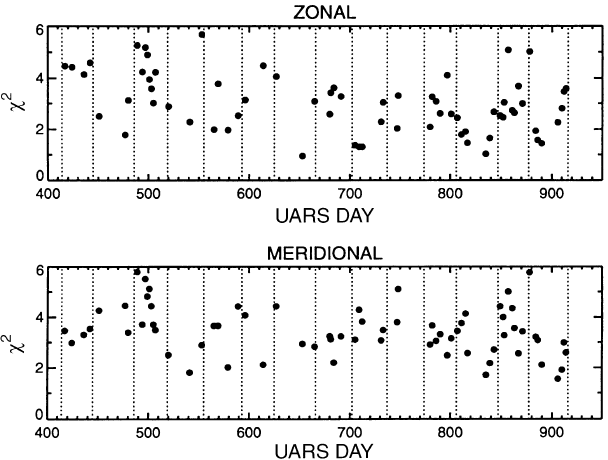
Fig. 14. Regression-fit reduced (cid:118) 2 values obtained from the regression analysis at an altitude of 95 km, as a function of time, for the zonal component ( upper panel ) and meridional component ( lower